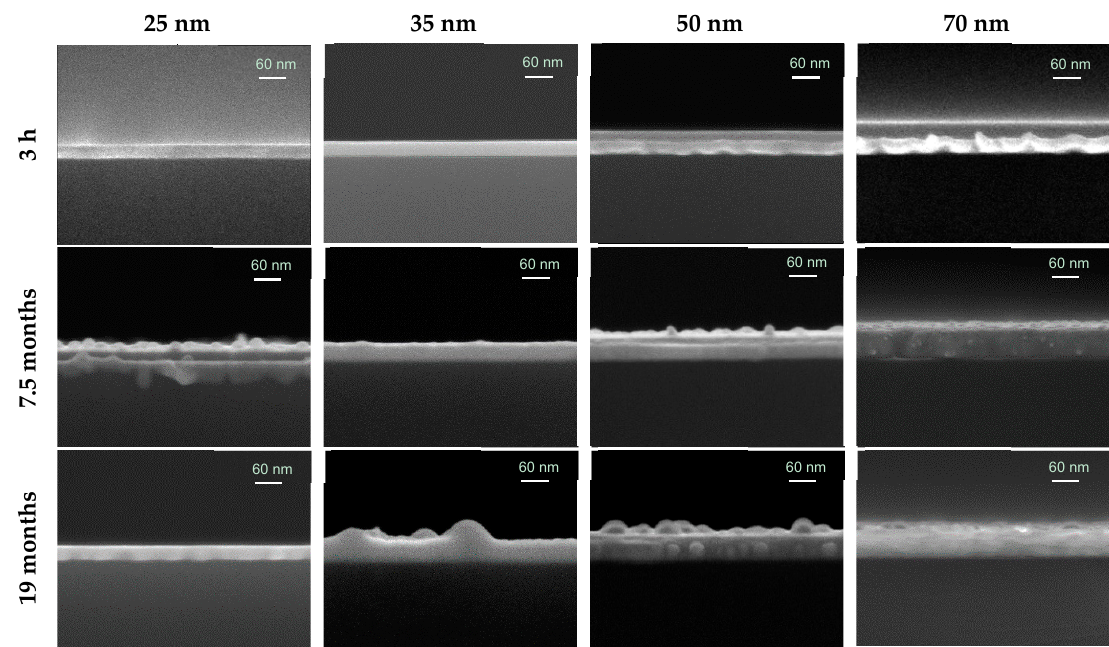
Figure 4. SEM cross section images of silver films of different thickness over time.